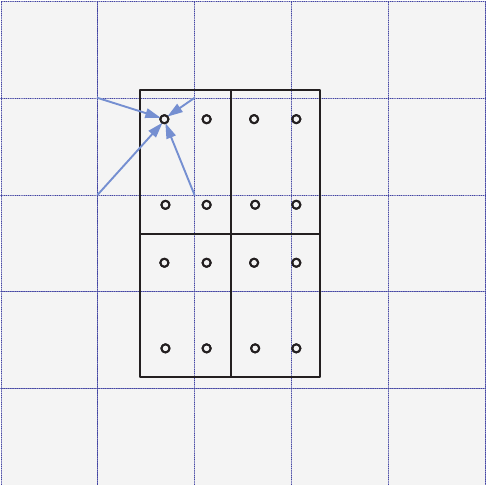
Figure 12. In Mask-RCNN, ROI Align calculates the value of each sampling point by bilinear interpolation from the nearby grid points on the feature